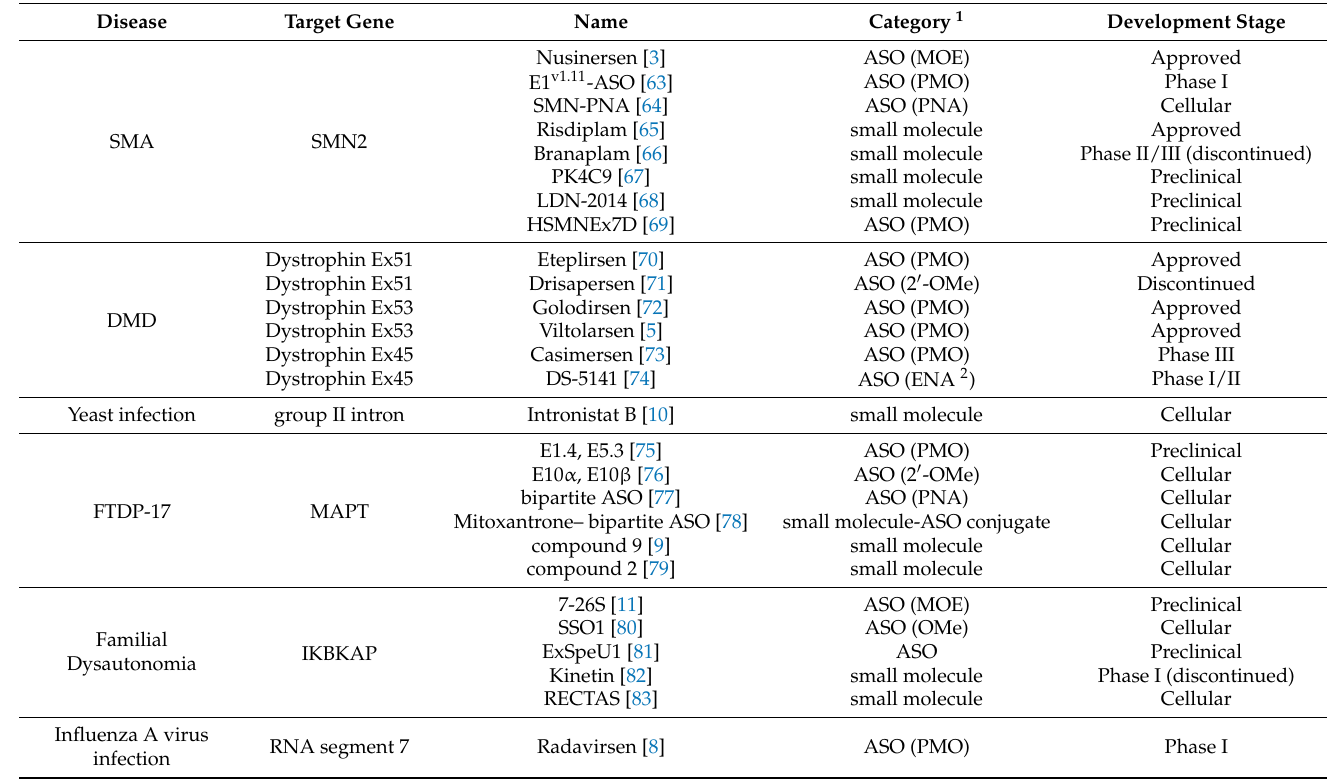
Table 2. Disease-related splicing